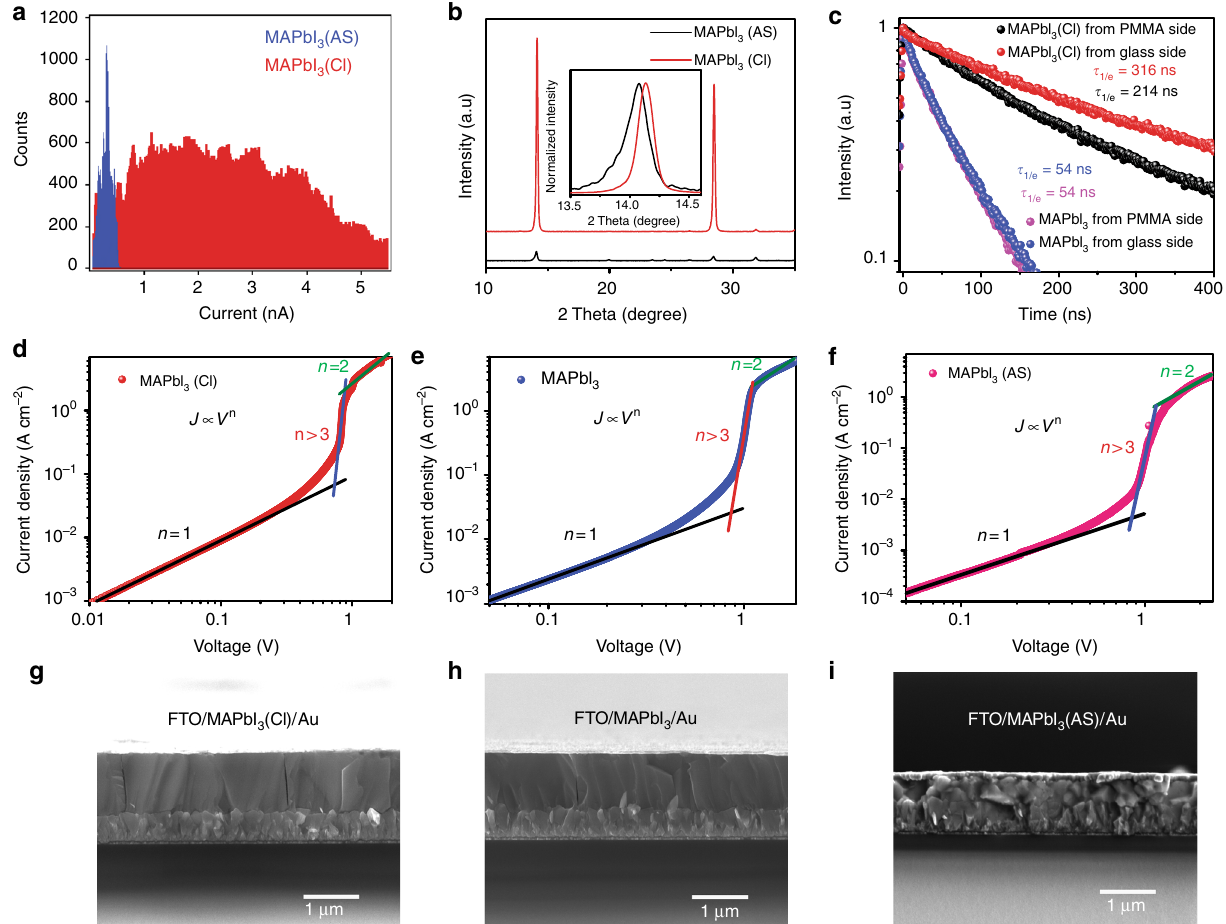
Fig. 5 Charge carrier transport behavior. a The light-induced current extracted from the c-AFM results and b XRD spectra for 1.1- μ m-thick MAPbI 3 (Cl) fi lm prepared by the HPbI 3 (Cl)/CH 3 NH 2 method and MAPbI 3 (AS) fi lm prepared by the antisolvent method. c Time-resolved photoluminescence (TRPL) decay for 1.1- μ m-thick MAPbI 3 (Cl) and MAPbI 3 fi lms prepared by the HPbI 3 (Cl)/CH 3 NH 2 method. d – f Current density – voltage ( J − V ) characteristics of devices with FTO/perovskite/Au con fi guration and g – i corresponding cross-sectional-view SEM images utilized for estimating the trap density and mobility for 1.1- μ m-thick MAPbI fi lms prepared by the HPbI fi lm prepared by the antisolvent method. 3 (Cl) and MAPbI 3 3 (Cl)/CH 3 NH 2 method, and MAPbI 3 (AS)